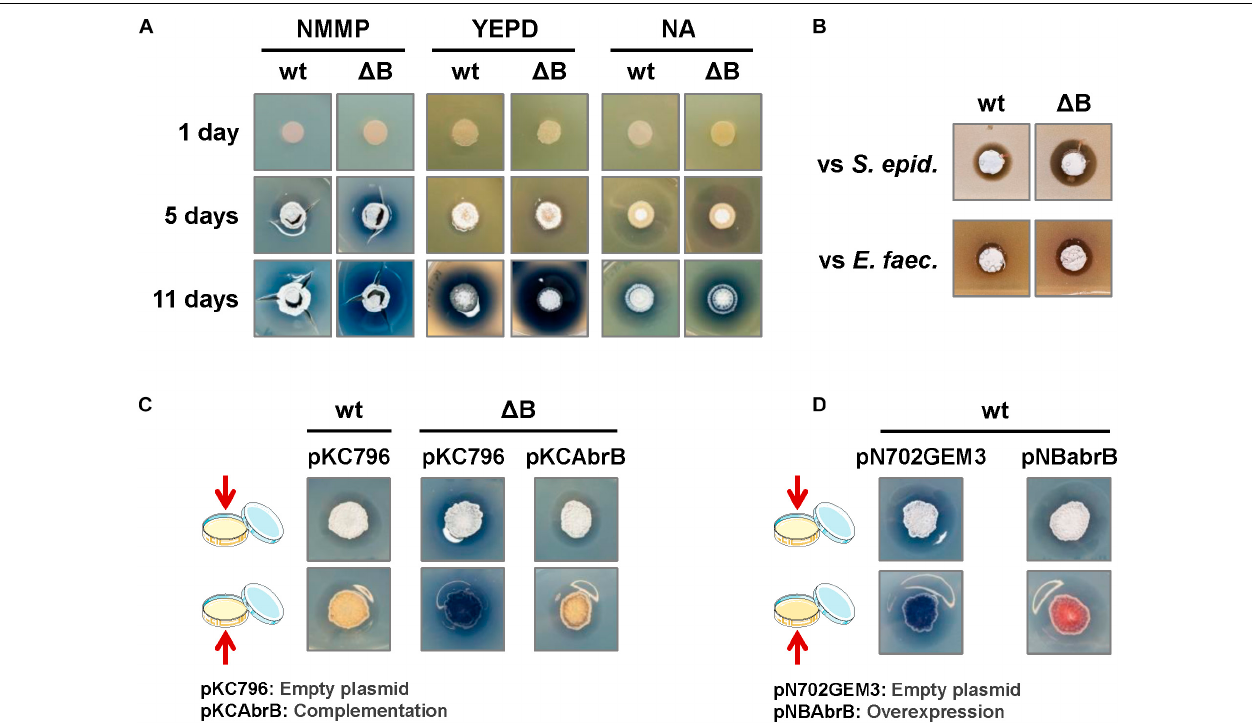
FIGURE 1 | Phenotypic analysis of the S. coelicolor mutant (cid:49) abrB strain. (A) Comparison of ACT production (blue halo around the colonies) and the differentiation of S. coelicolor M145 wild-type strain (wt) and its deletion mutant (cid:49) abrB ( (cid:49) B) growing during 1, 5, and 11 days on several types of media (NMMP, YEPD, and NA). Photos of the top view of the plates. (B) Antagonistic assay: inhibitory effect of S. coelicolor M145 wild-type strain (wt) and its mutant (cid:49) abrB ( (cid:49) B) growing on a lawn of the Gram+ bacteria Staphylococcus epidermidis ( S. epid. ) and Enterococcus faecalis ( E. faec. ). Photos of the top view of the plates. (C) Complementation of ACT production in S. coelicolor M145 (cid:49) abrB mutant ( (cid:49) B) with the integrative plasmid pKCAbrB after 5 days on NMMP medium. The wt and (cid:49) B strains carrying the empty plasmid (pKC796) were used as controls to compare the phenotypes. Photos of the top and bottom views of the plates. (D) Overexpression of the AbrB1/B2 system (pNBabrB) compared with the empty plasmid (pN703GEM3), used as control, in the wild-type strain (wt) on NMMP medium after 10 days. Photos of the top and bottom views of the plates.